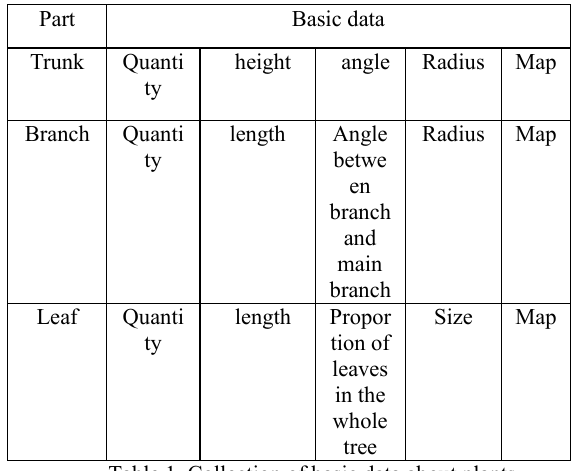
Table 1. Collection of basic data about